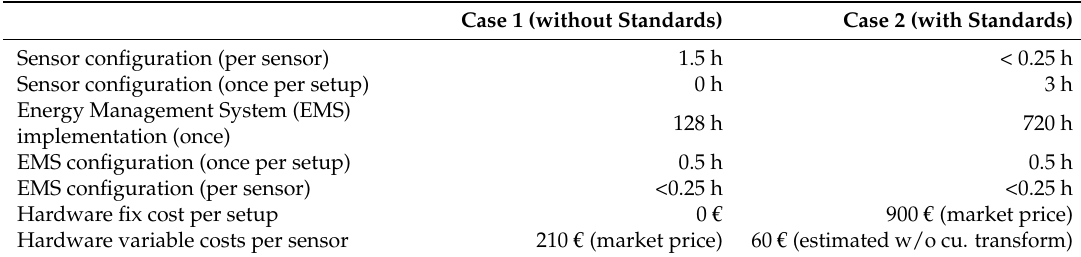
Table 3. Cost comparison (h = working